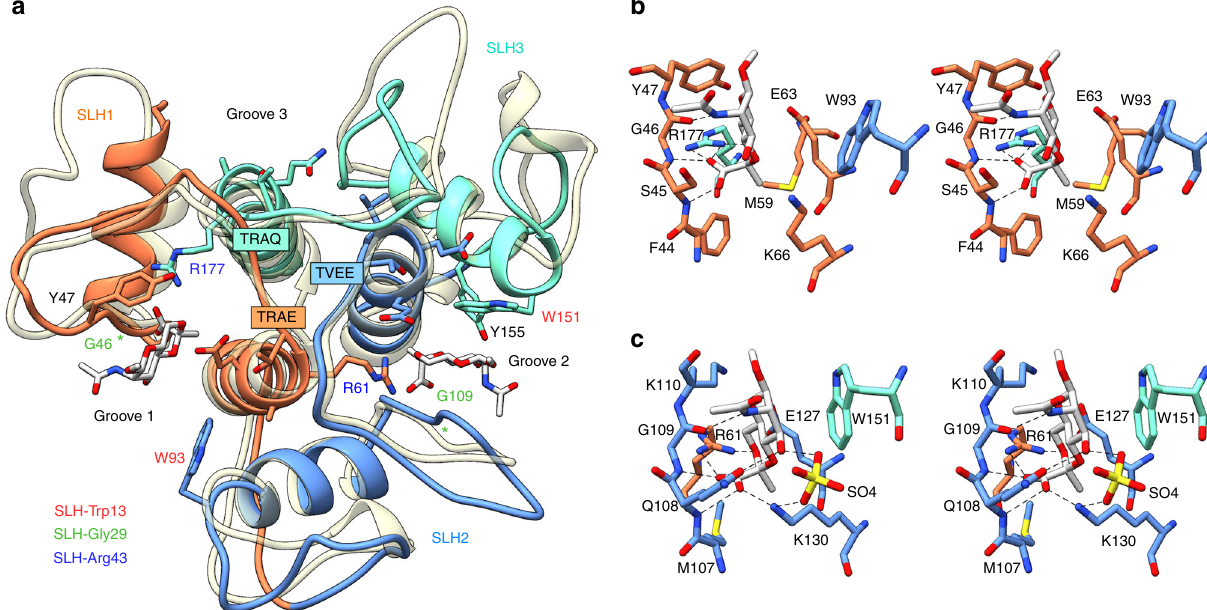
Fig. 3 SpaA SLH structure and SCWP ligand binding. a Ribbon diagram of SpaA SLH with bound monosaccharide (PDB 6CWI; Supplementary Table 1) and B. anthracis Sap (PDB 3PYW) overlayed in tan. SpaA SLH is colored with SLH1 orange, SLH2 blue, and SLH3 aquamarine. Residue labels are colored by conserved SLH domain residue (legend bottom left). Stereo views of monosaccharide binding in G1 and G2 are shown in b and described for the SLH domains of B . anthracis Sap 39 (Fig. 3a, G3). The TRAE and TRAQ motifs each contribute to two of the Supplementary Fig. 1, and Supplementary Table 1). The TRAE, three grooves, as their arginine residues thread under the con- TVEE, and TRAQ motifs of SpaA are located at the N-termini of necting loops of the adjacent SLH domains and into the neigh- the core helices adjacent to three grooves (labeled here G1, G2, and boring grooves. In the case of SLH2, Val125 of the TVEE motif